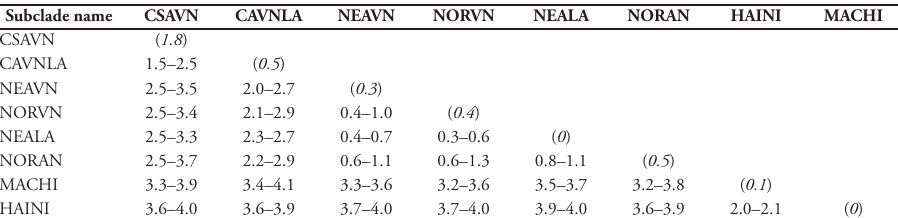
CSAVN: Central & southern Annamites, Vietnam; CAVNLA: Central Annamites, Vietnam and Laos, NEAVN: North-east- ern Vietnam; NORVN: Northern Vietnam; NEALA: North-eastern Laos; NORAN: Northern Annamites; MACHI: Main- land China; HAINI: Hainan